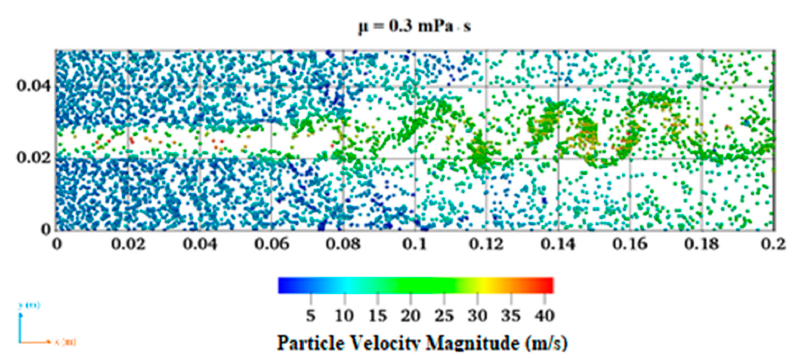
Figure 6. Turbulent flow attributed to the ultra-low fluid viscosity.